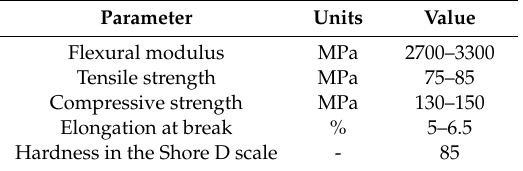
Table 1. Properties of the epoxy resin LG285 with the HG285 curing agent